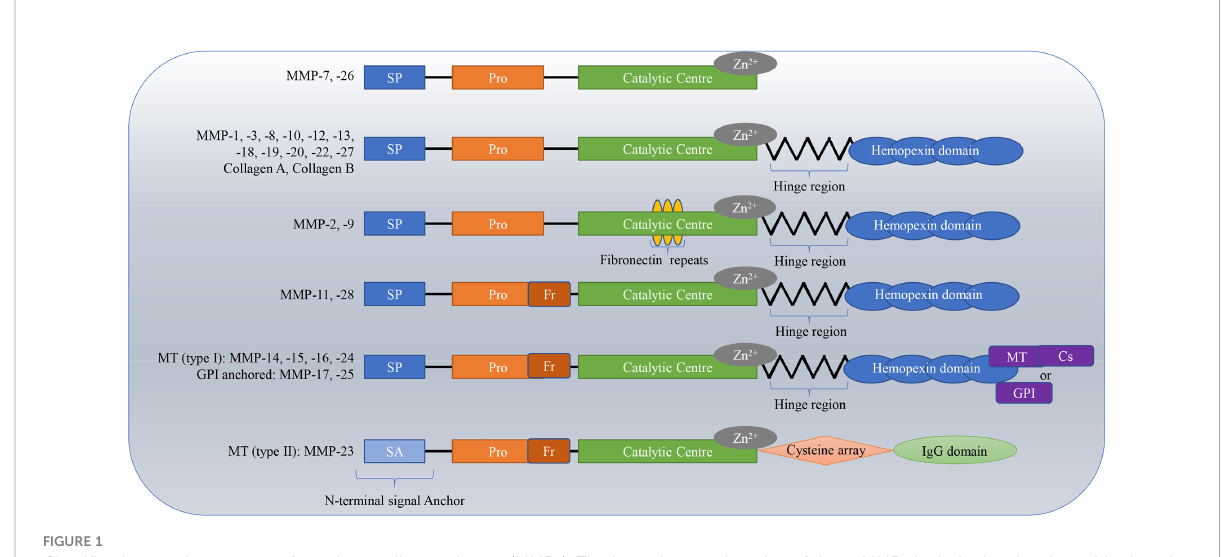
FIGURE 1 Classi fi cations and structures of matrix metalloproteinases (MMPs). The homologous domains of these MMPs include the signal peptide domain (SP), propeptide domain (Pro), catalytic domain, and hinge region or linker peptide along with a hemopexin domain. The hinge region connects the catalytic domain to the hemopexin domain. Matrilysins lack a C-terminal hemopexin-like domain linked by a hinge or linker region; Gelatinases have special additional fi bronectin repeats in the catalytic domain; MT-MMPs have a C-terminal transmembrane domain with a short cytoplasmic tail. MT, membrane-type; Cs, cytosolic; GPI,